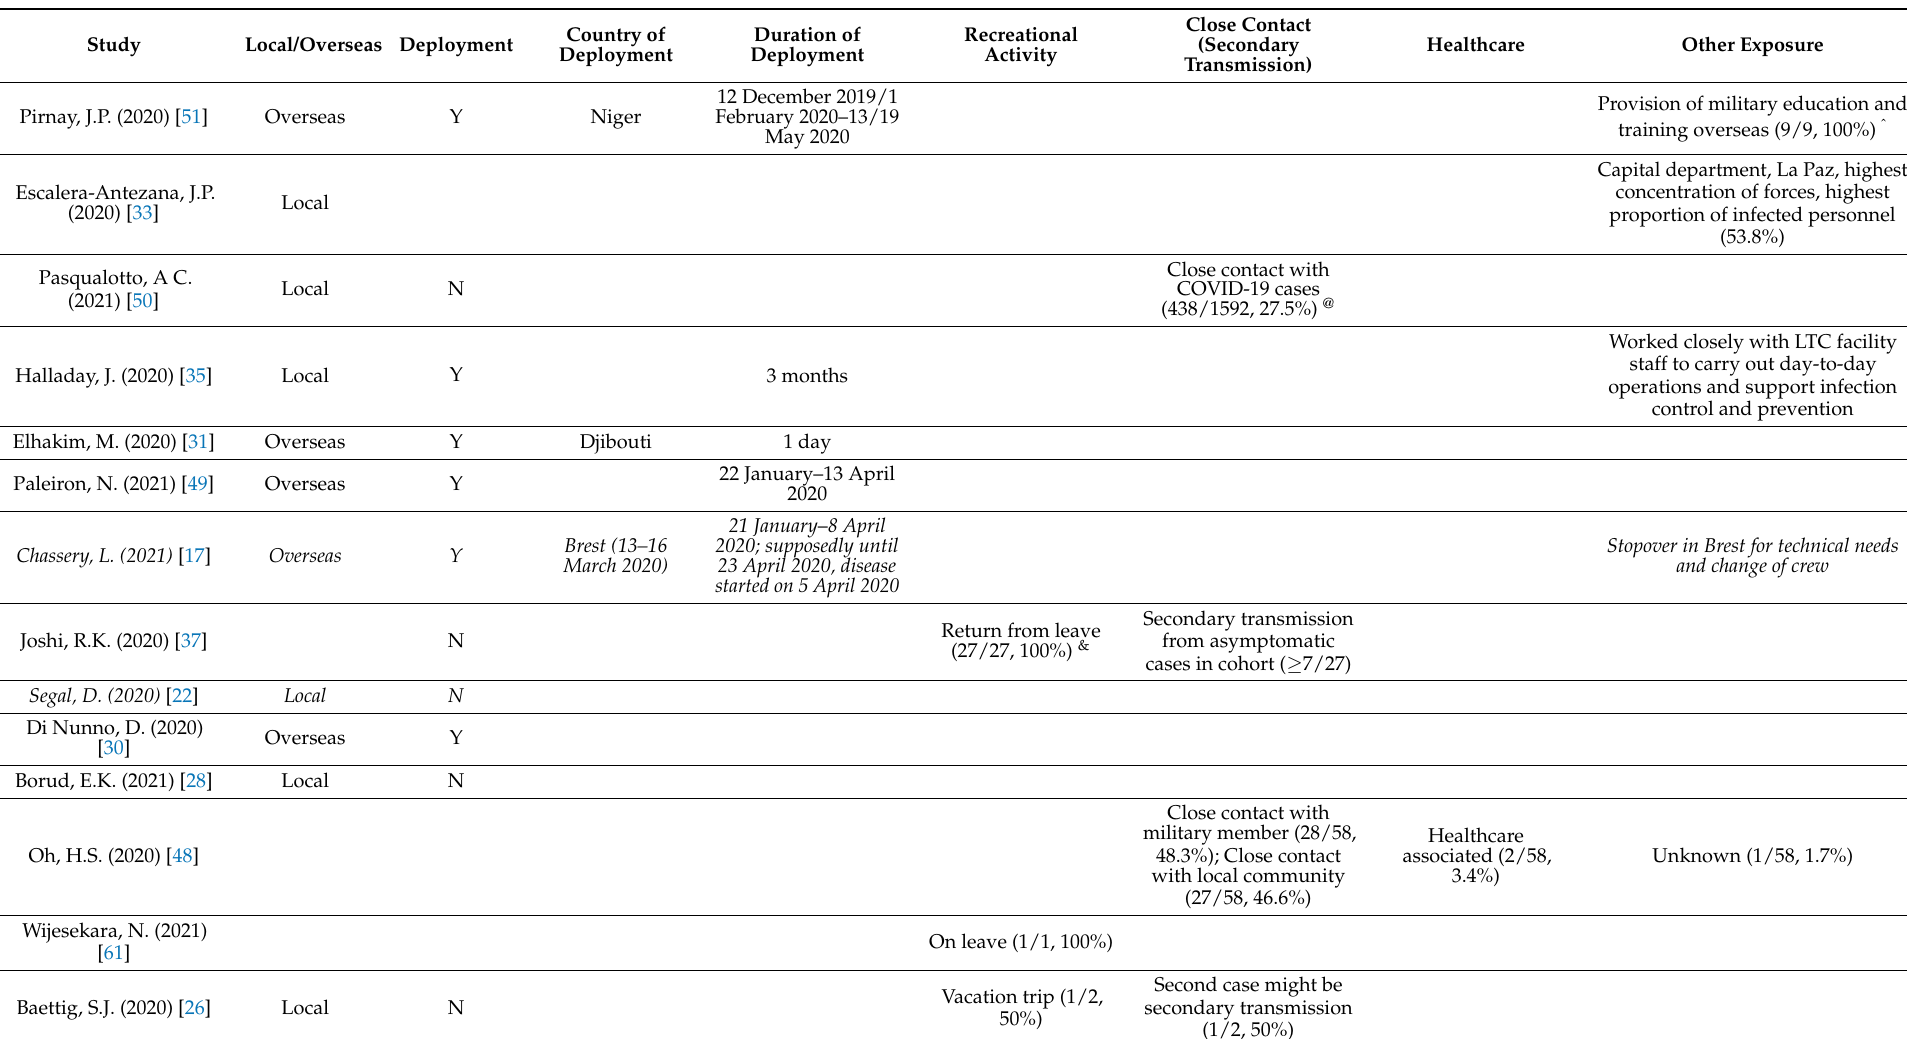
Table 3. Possible COVID-19 exposures reported by cases in included studies (only those with exposures presented